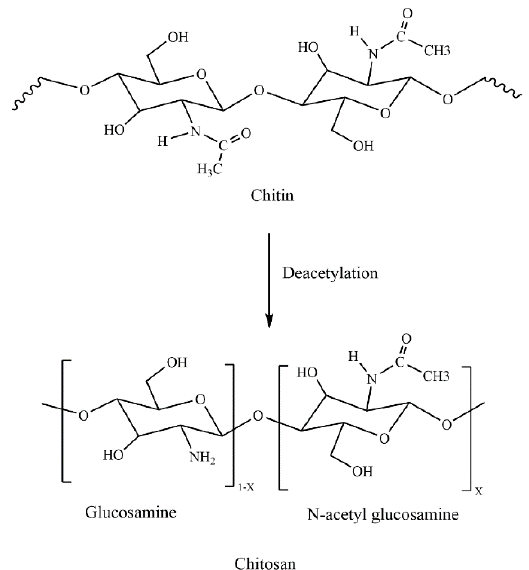
Figure 4. Chemical structures of chitin and chitosan. Reprinted from [64], originally published under a CC-BY 4.0 license. a CC-BY 4.0